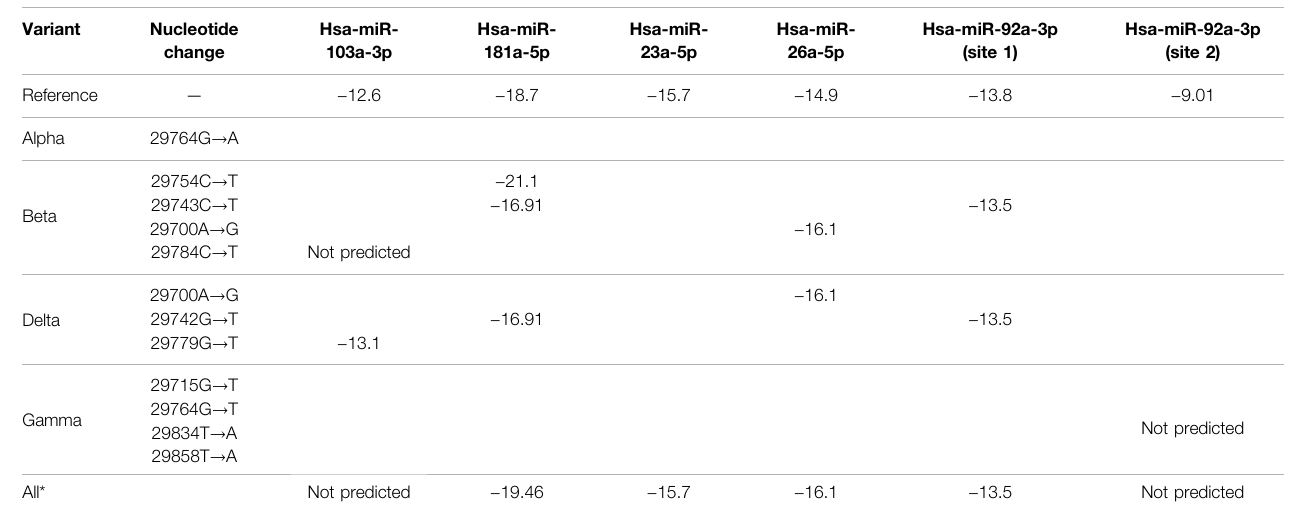
TABLE 3 | Binding energy prediction in 3 ′ UTRs of